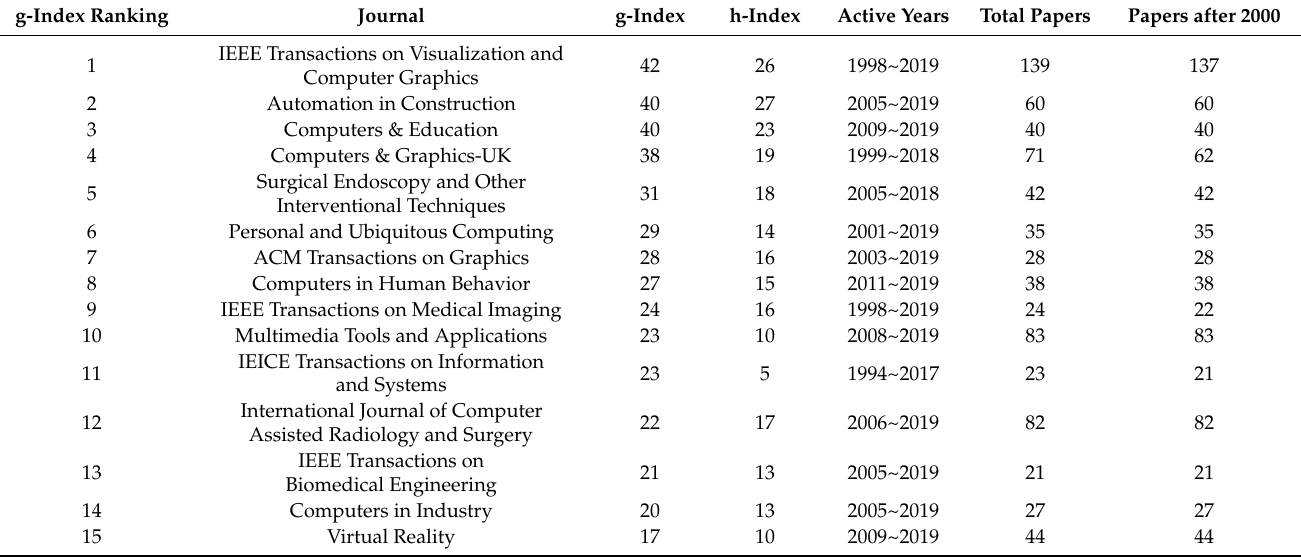
Table 1. Top 20 most influential journals in the AR